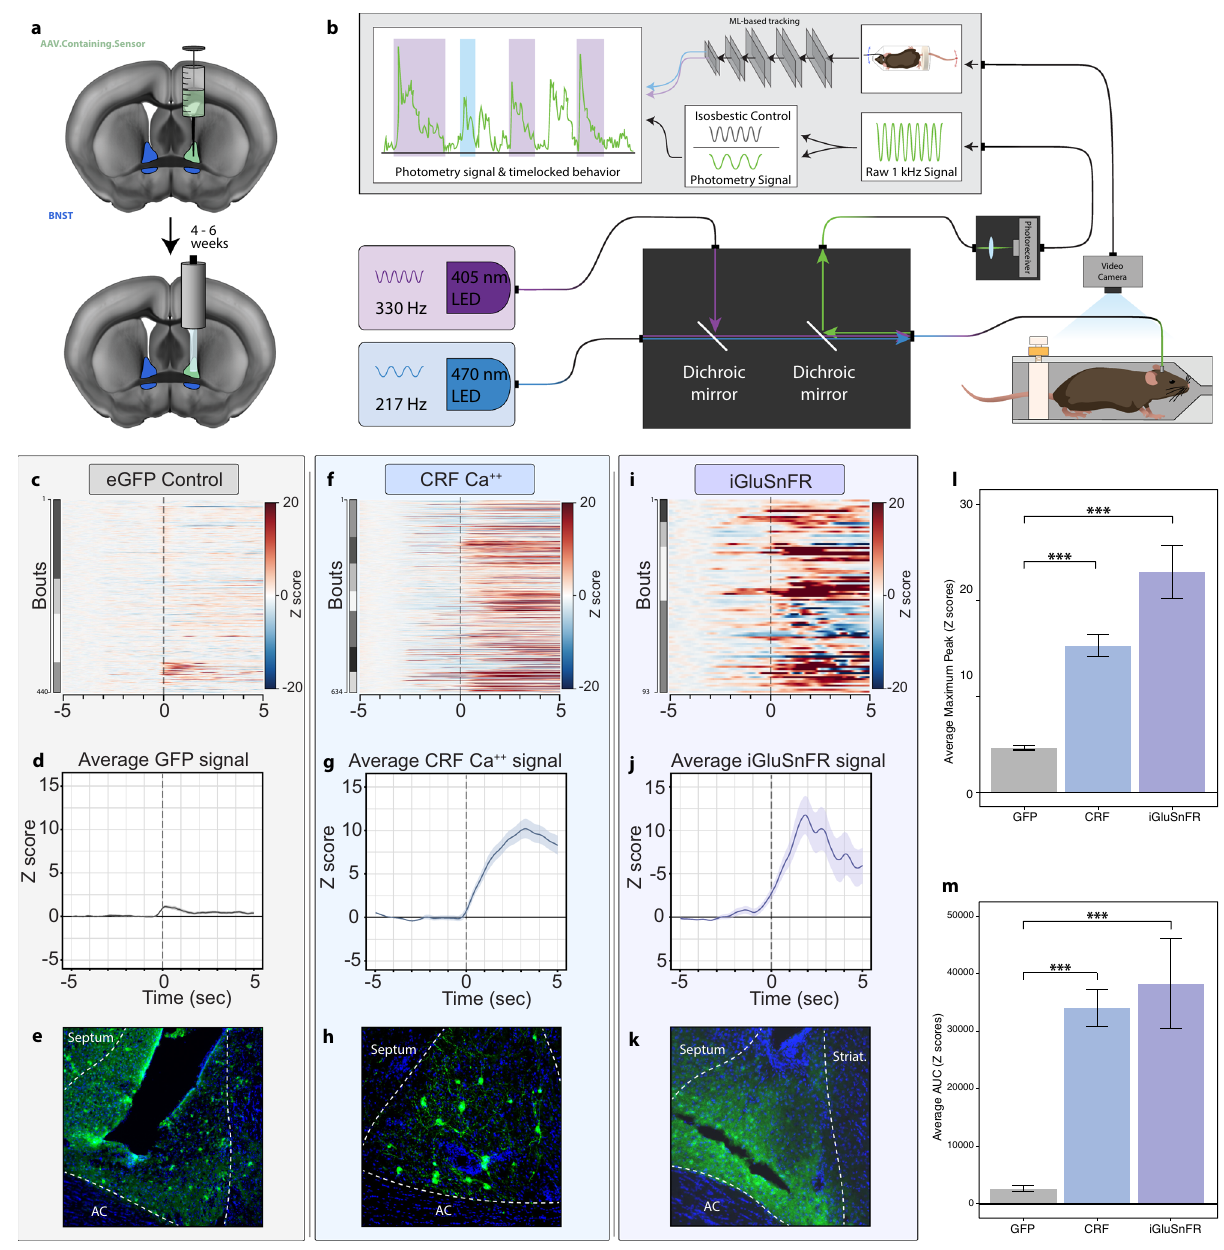
Fig. 3 Calcium signals from BNST CRF neurons and BNST glutamate transients are associated with struggling bouts. a Diagram of sensor-containing virus injection and fi ber photometry implant into the BNST. Viral constructs coded for either eGFP control, Cre-dependent GCaMP, or SF-iGluSnFR. b Schematic of two-channel fi ber photometry system with the ability to implement an isosbestic control. Signal is time-locked to machine learning-based scoring of RESTRAINT device behavior. c – e Photometry recording from mice that received an injection of AAV5.eGFP in the BNST. c eGFP control heatmap of time-locked bouts. d Average eGFP signal. Lighter shading: s.e.m. across all bouts. e Example image of eGFP expression in the BNST. f – h